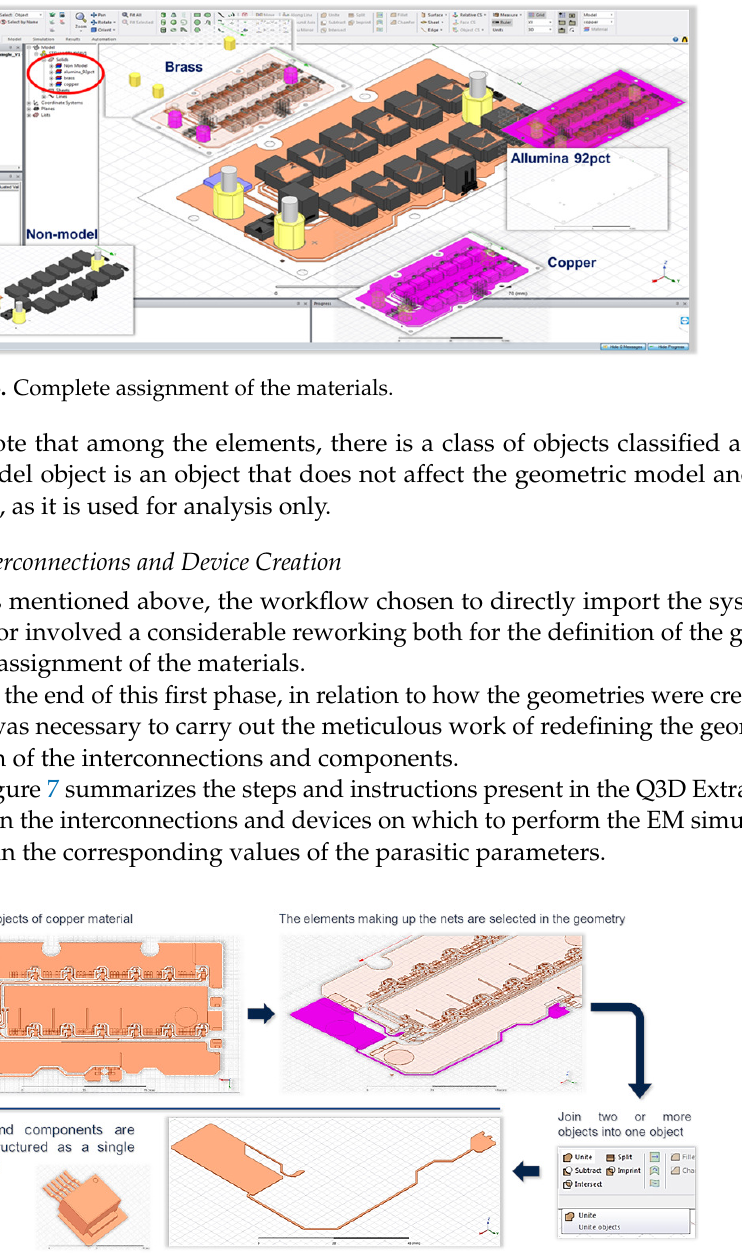
Figure 7. Elementary geometric objects must be properly joined to create board interconnects and